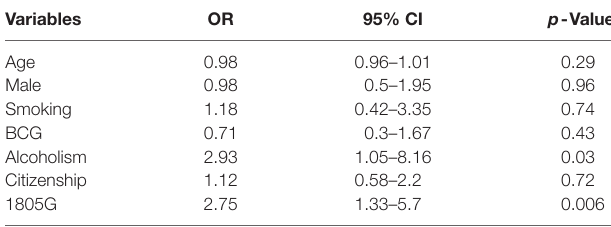
TaBle 5 | Multivariate logistic regression for multibacillary TB.